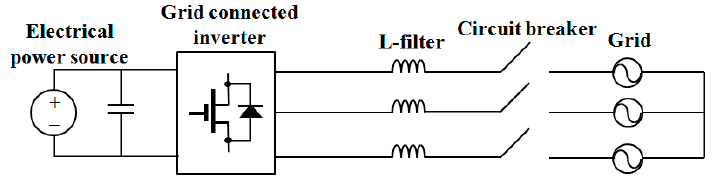
Figure 1. Configuration of a grid connected inverter.